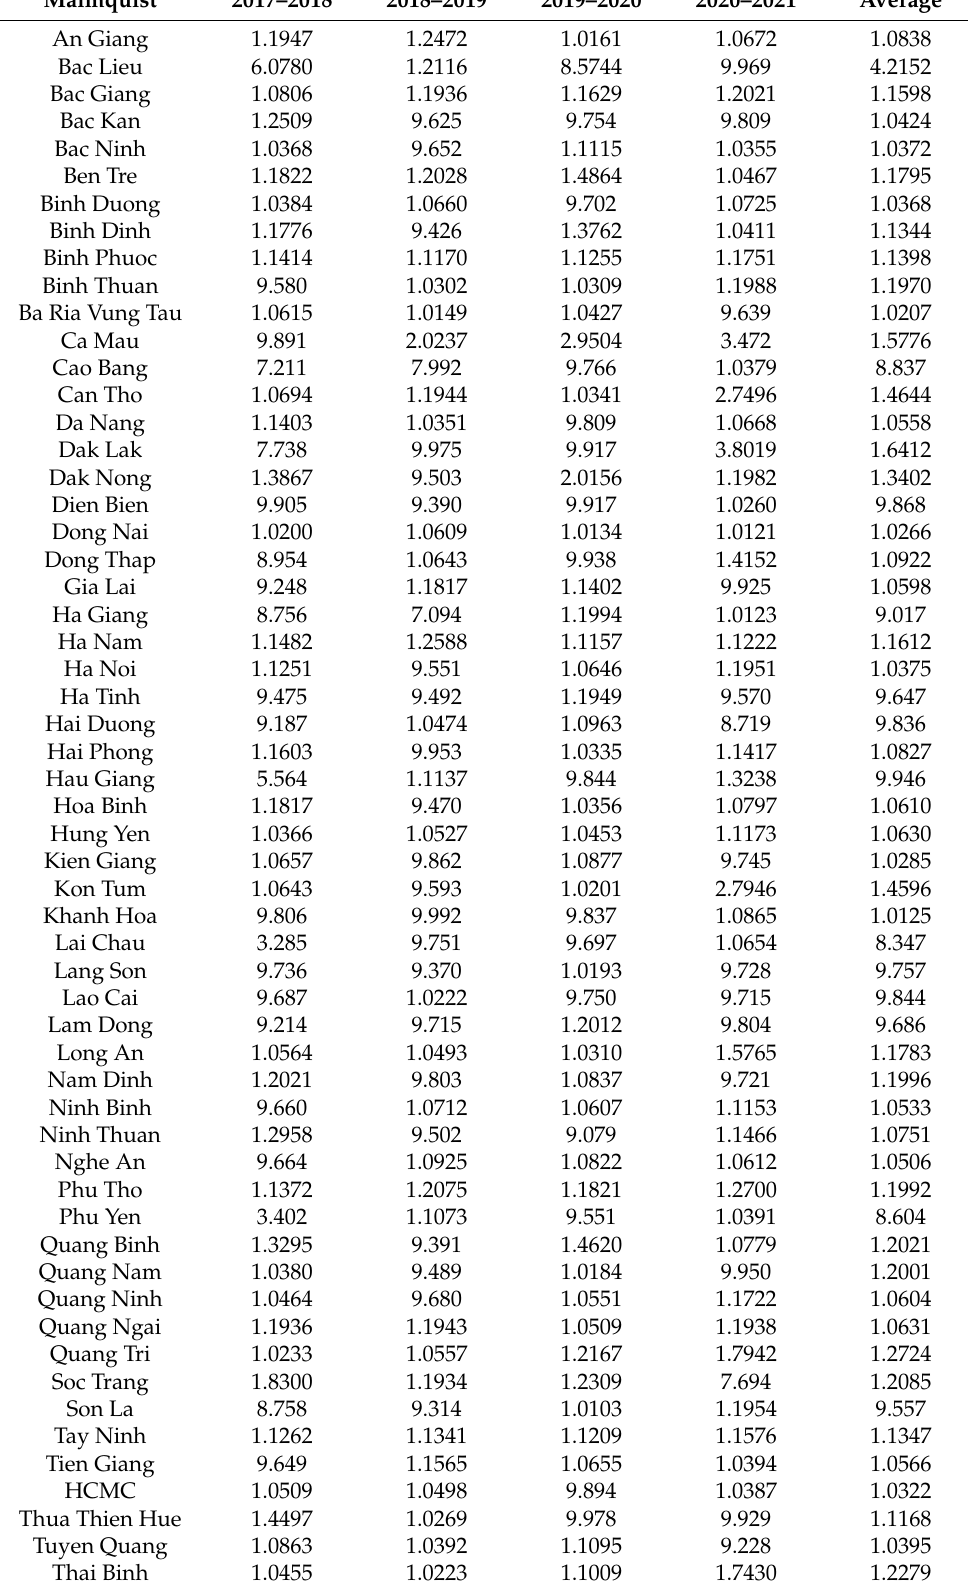
Table A3. Malmquist productivity index (2017–2021).